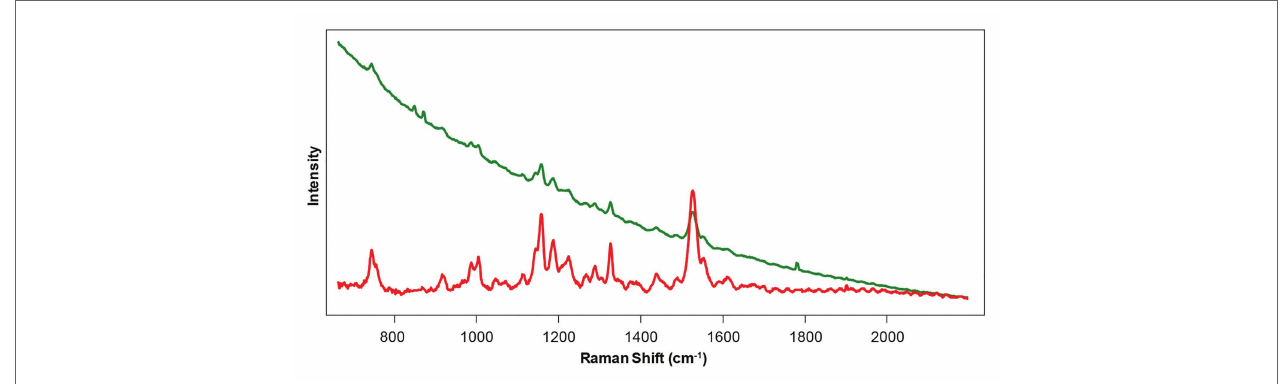
FIGURE 3 | Raw (green) and baseline-corrected (red) Raman spectra collected from a rose leaf with 785 nm